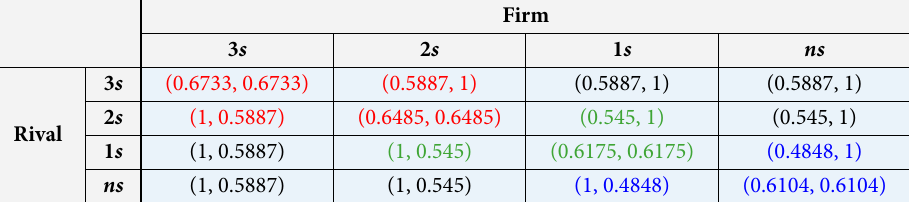
Table 9. Technological transition: four observations, risk-averse DM, and signals on X 2